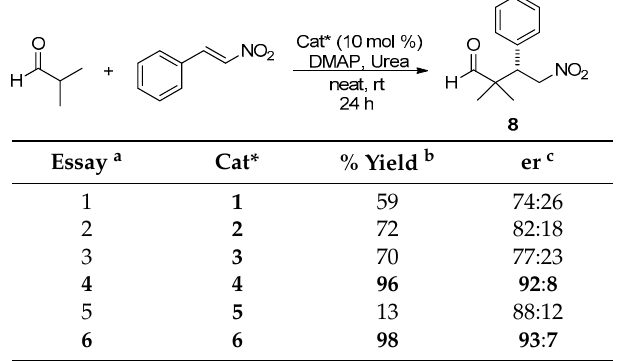
Table 5. Michael addition reaction of isobutyraldehyde to trans - β -nitrostyrene organocatalyzed by α , β -dipeptides 1 – 6 .